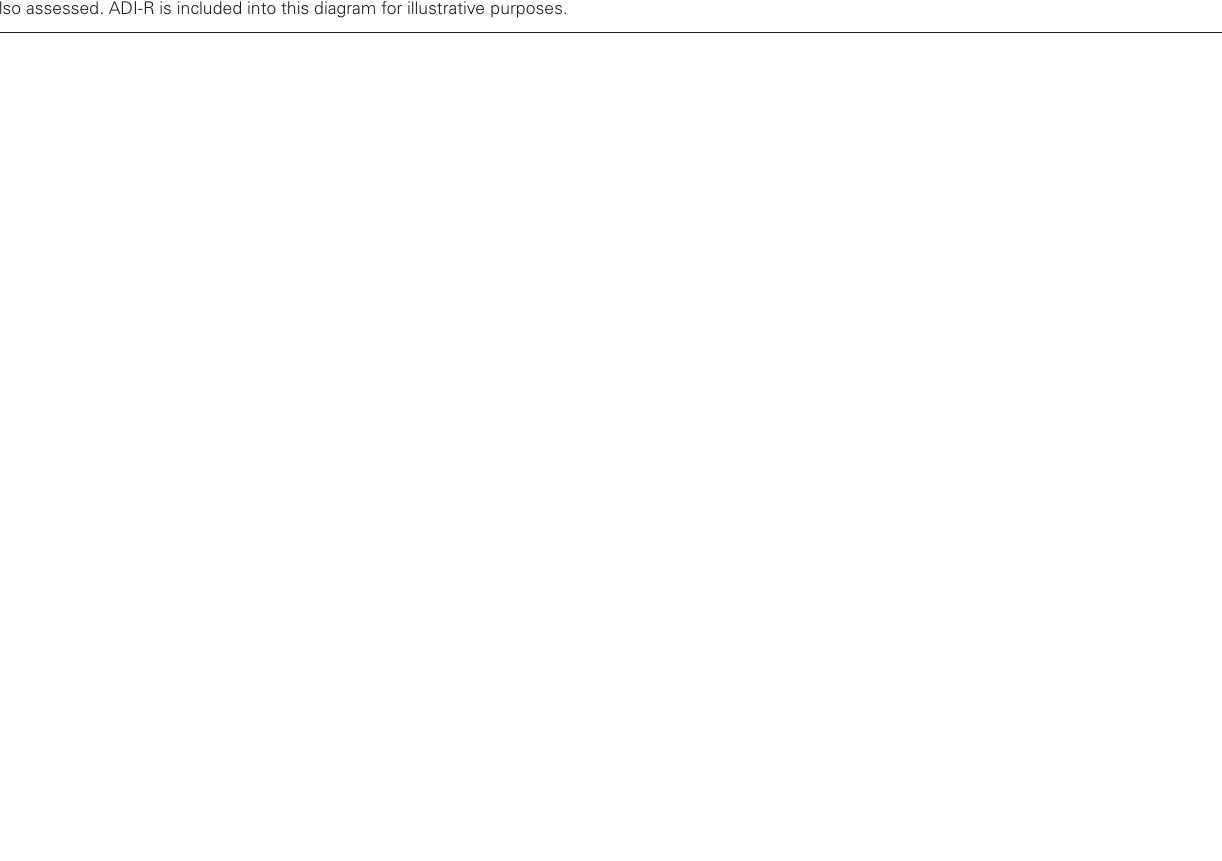
FIGURE A1 | Changes of irritability [Clinical Global Impression Severity Scale (CGI)] and of core symptoms of autism (ADI-R) in the course of treatment. The CGI-Severity Scale according to Guy (1976) is displayed here for addressing the target symptoms of irritability expressed by the patient during the course of treatment. The scale has a range from 1 (normal) to 7 (extremely ill). Time point 0 corresponds to the initial onset of DBS. Arrows indicate substantial changes induced by stopping (week 44) and restarting (week 48) DBS, respectively. After resuming DBS, CGI was constantly rated at 4 (moderately ill). The CGI was measured for the last time 59 weeks after restarting DBS treatment. CGI was determined on the same day when the ADI-R was also assessed. ADI-R is included into this diagram for illustrative